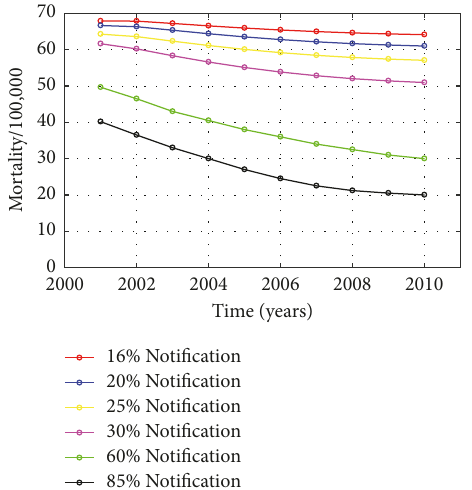
Figure10: Hypothesis4: theresultof10-yearsimulationofthemodel using different notification rates. Each point on the curve represents the mortality in the sick population after the model is simulated for 10 years with the corresponding notification rate on the